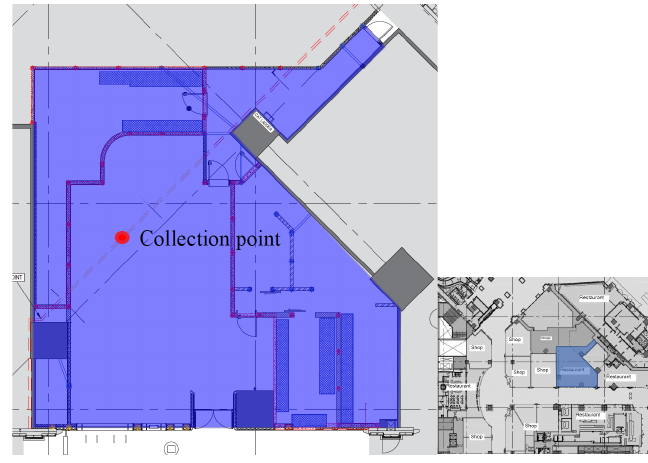
Figure 2. Layout of the renovation area .